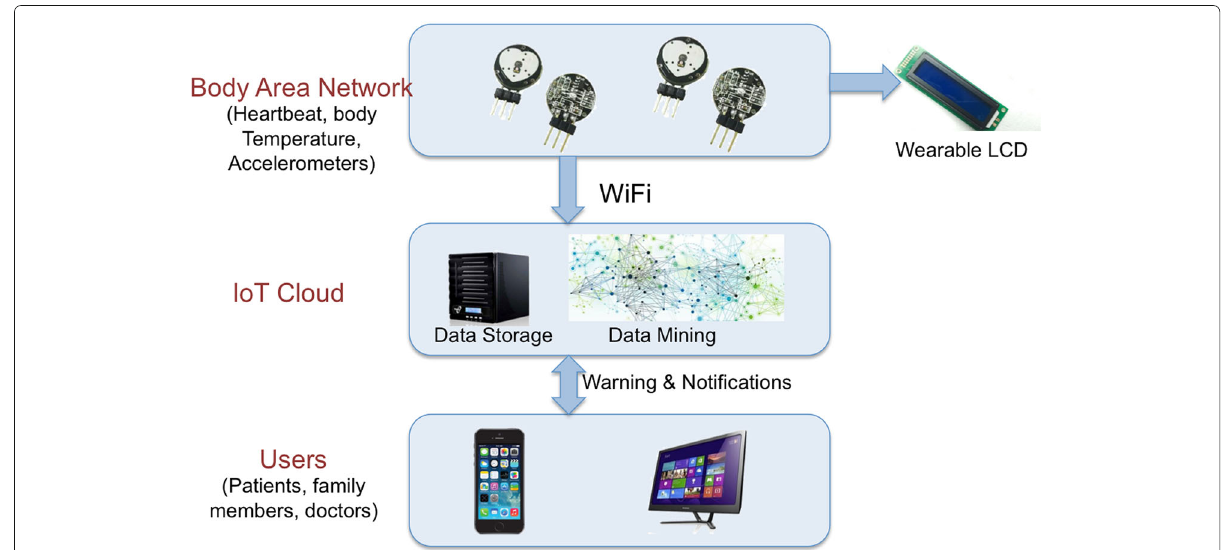
Fig. 2 The framework of the WISE system. The overall design of the proposed WISE system